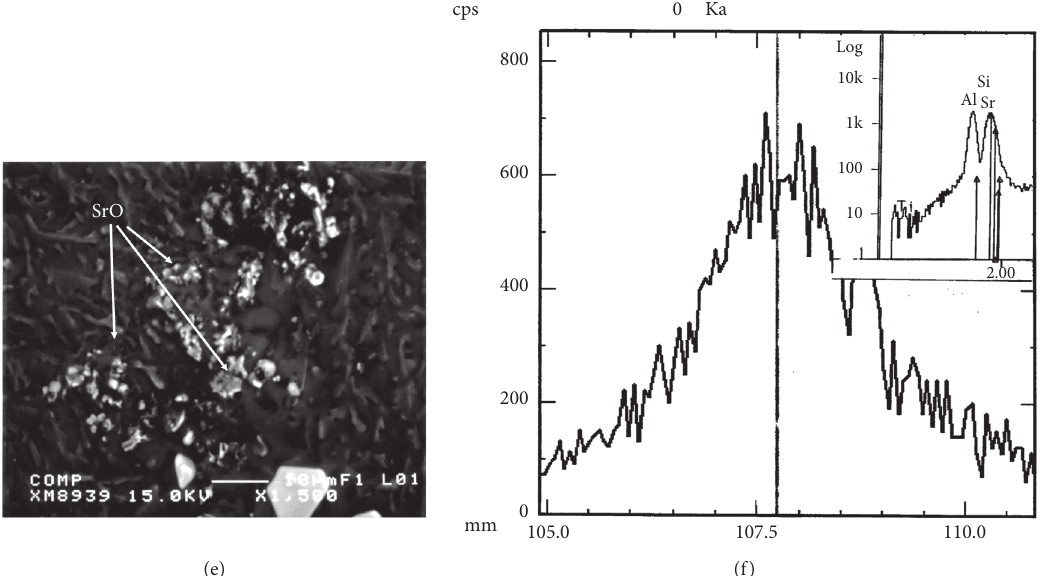
Figure 9: Porosity formation in Sr-modified A356 alloy: (a) general distribution of porosity (0.25 ml/100g Al), (b, c) H (d) optical micrograph shows presence of SrO particles at the bottom of the pore, (e) backscattered electron image of SrO particles viewed in a gas pore-bright spots (Sr atomic number is 38 whereas Al atomic number is 13), (f) O 2 -X-ray spectrum obtained from the particles in (e). Average dendrite arm spacing is about 25 μ